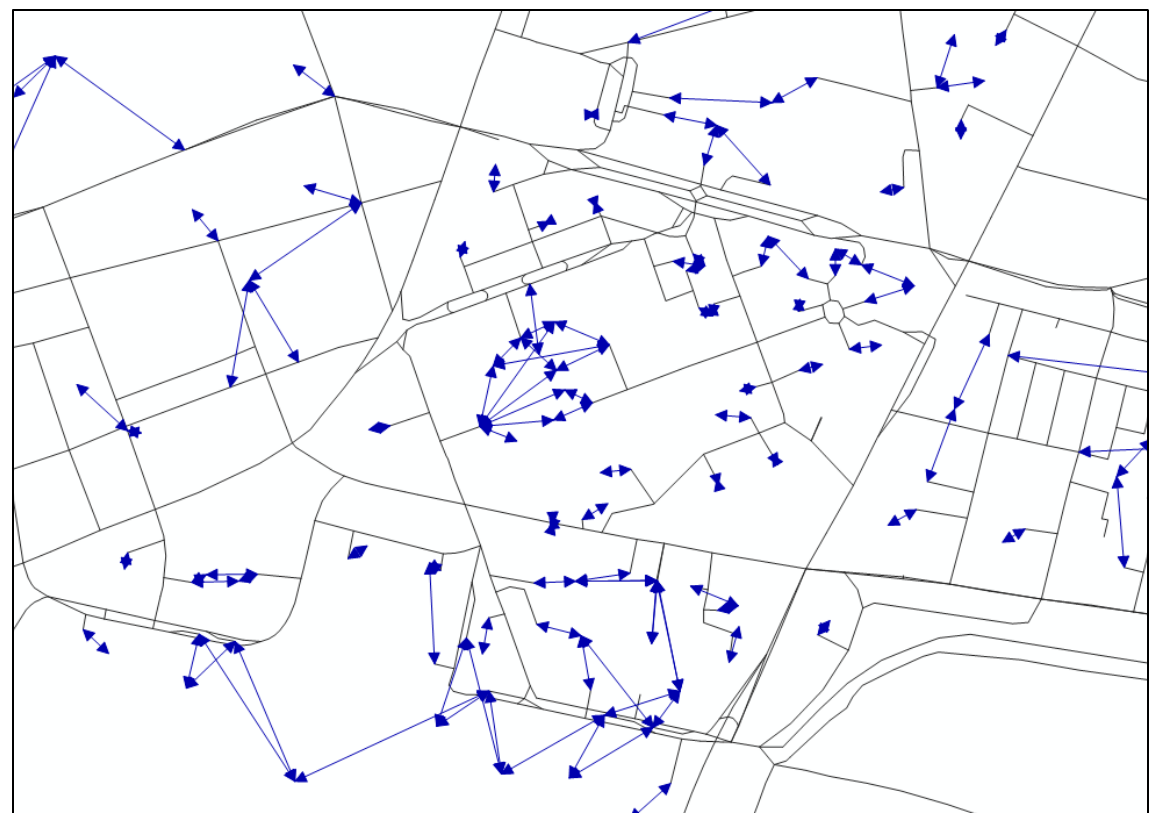
Figure 8. Example of the distribution of zonal activities on the road infrastructure for the city centre of Bratislava (blue arrows are the connectors from the centroid of the zone to the street in model. One zone has a possibility to connect more streets).